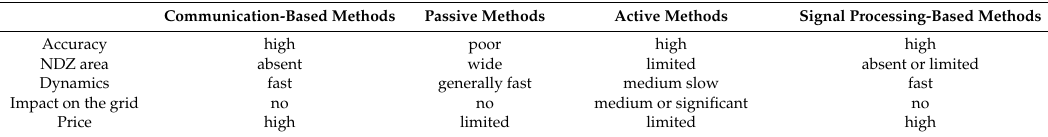
Table 1. Performances of the islanding detection methods.